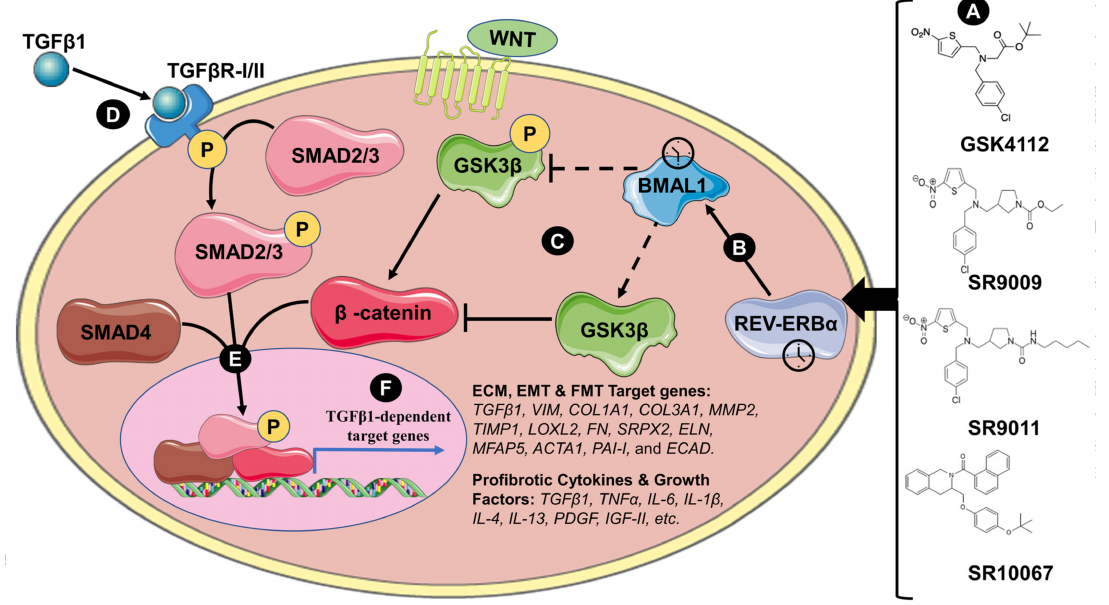
Figure 2. Targeting the molecular clock using synthetic REV-ERB agonists to modulate TGF β 1- mediated ECM and ECM signaling mechanisms. ( A ) Pharmacologically targeting the molecular